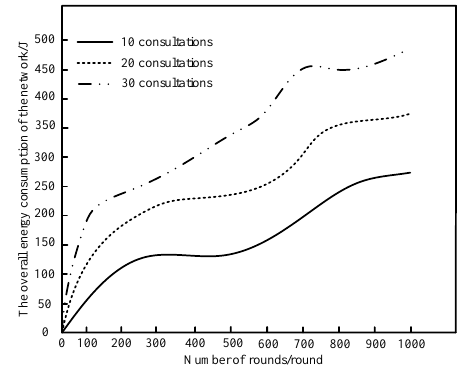
Figure 6. Overall energy consumption of wireless sensor